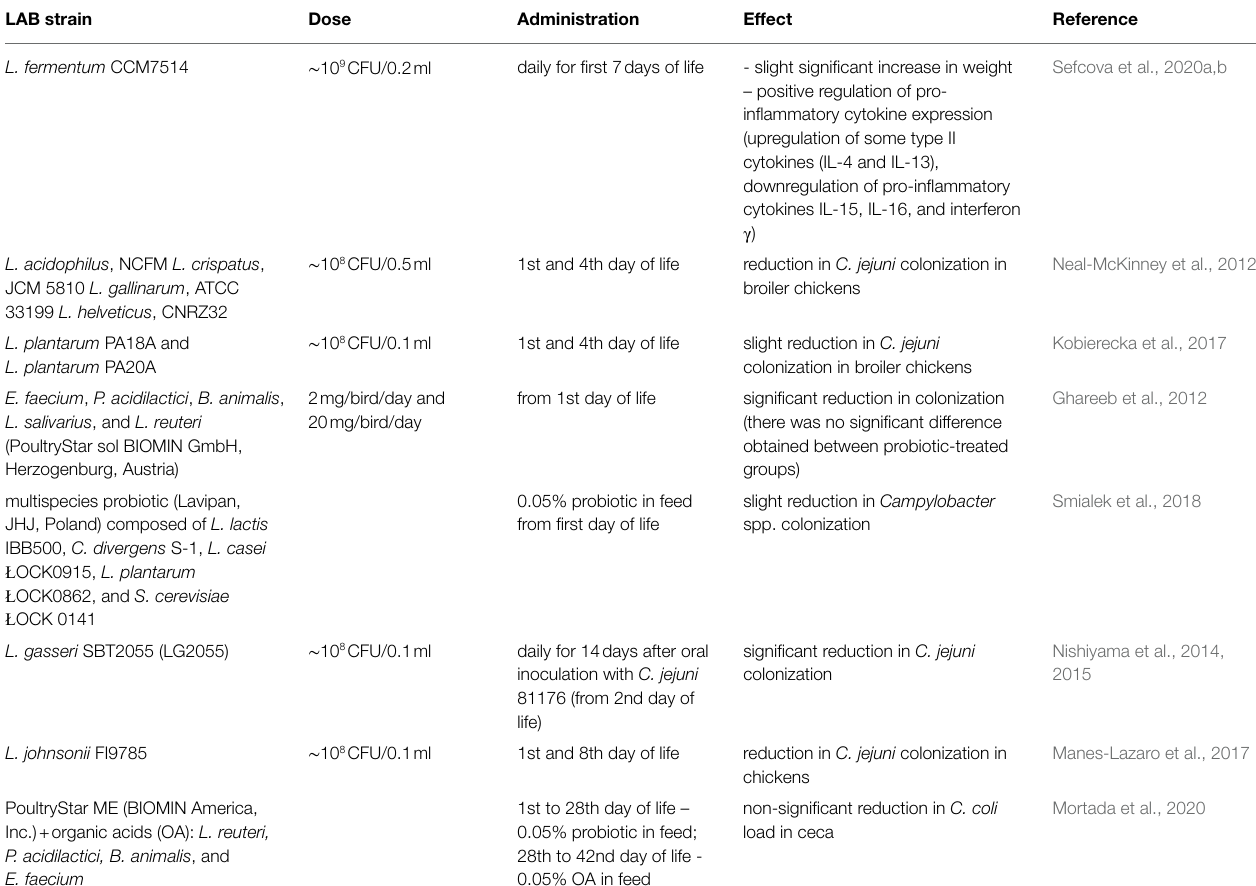
TABLE 2 | LAB as anti- Campylobacter probiotics for